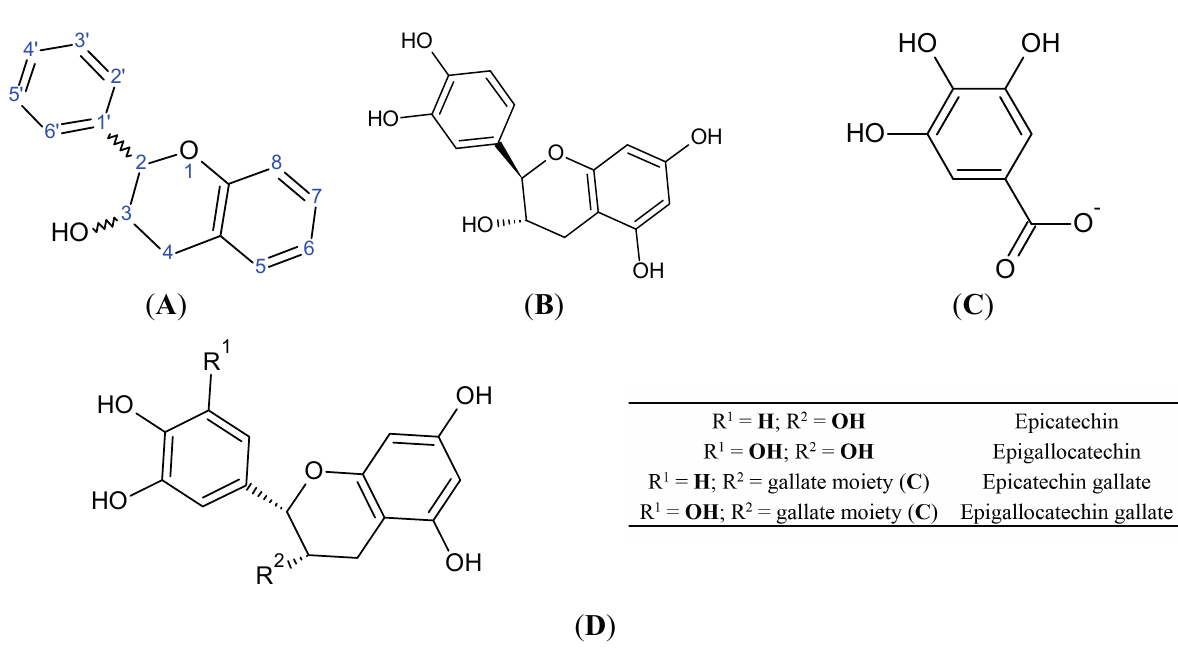
Figure 2. ( A ) General structural formula of flavan-3-ols; ( B ) (+)-catechin (2 R ,3 S ), the more common of the two catechin enantiomers; ( C ) gallate moiety; ( D ) Substituents of catechin